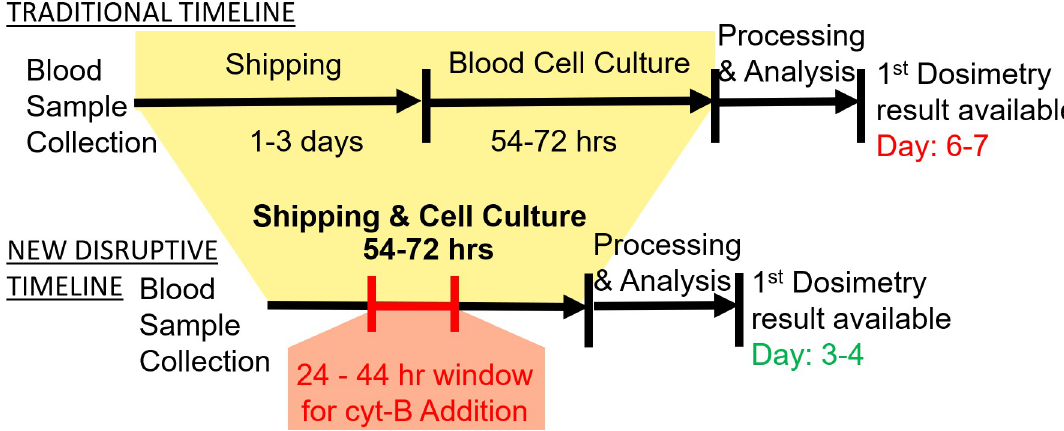
Fig 1. Timelines of the traditional and new disruptive CBMN assay logistics. Addition of cyto-B within a 24–44 hour window duration transportation is critical for the success of the new biodosimetry logistics to dramatically cut down the response time, which will be implemented by our